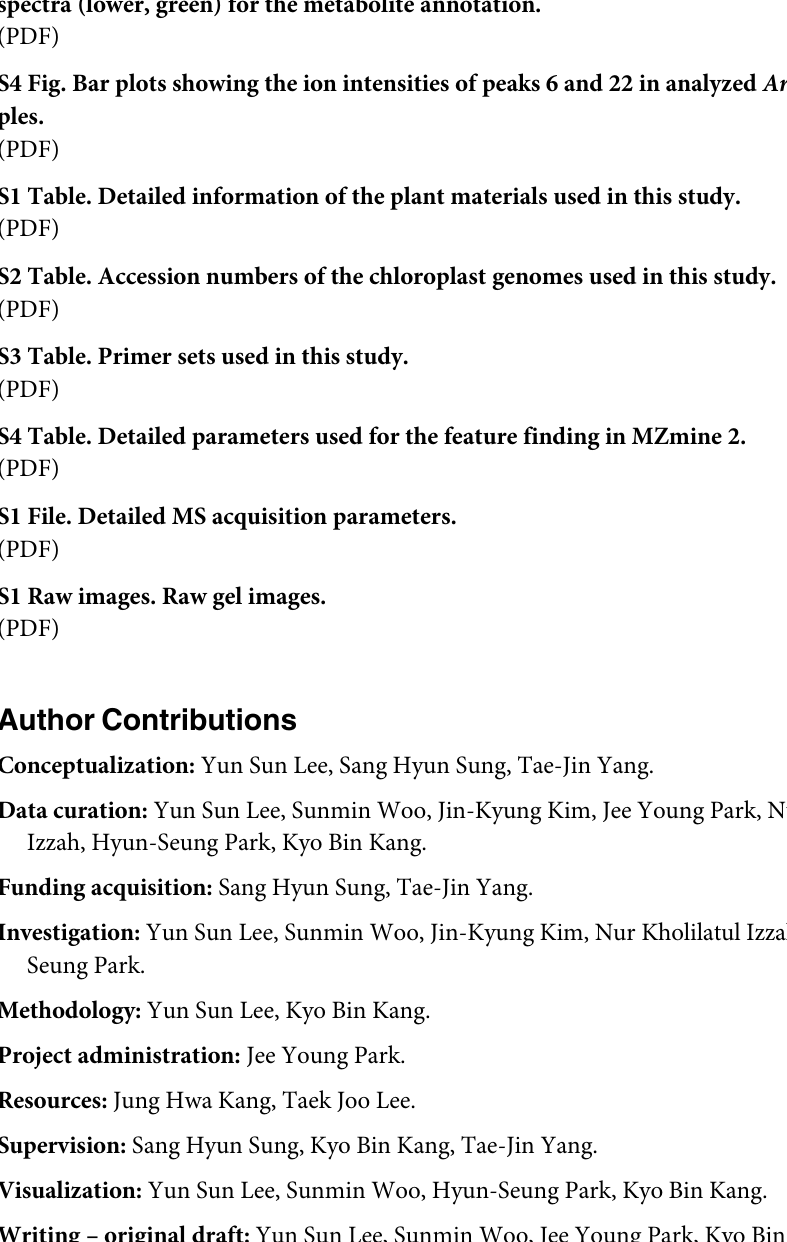
S3 Fig. The mirror plot of experimental MS/MS spectra (upper, black) and GNPS reference spectra (lower, green) for the metabolite annotation. (PDF) S4 Fig. Bar plots showing the ion intensities of peaks 6 and 22 in analyzed Artemisia sam- ples. S1 Table. Detailed information of the plant materials used in this study. (PDF) S2 Table. Accession numbers of the chloroplast genomes used in this study. (PDF) S3 Table. Primer sets used in this study. (PDF) S4 Table. Detailed parameters used for the feature finding in MZmine 2. (PDF) S1 File. Detailed MS acquisition parameters. S1 Raw images. Raw gel